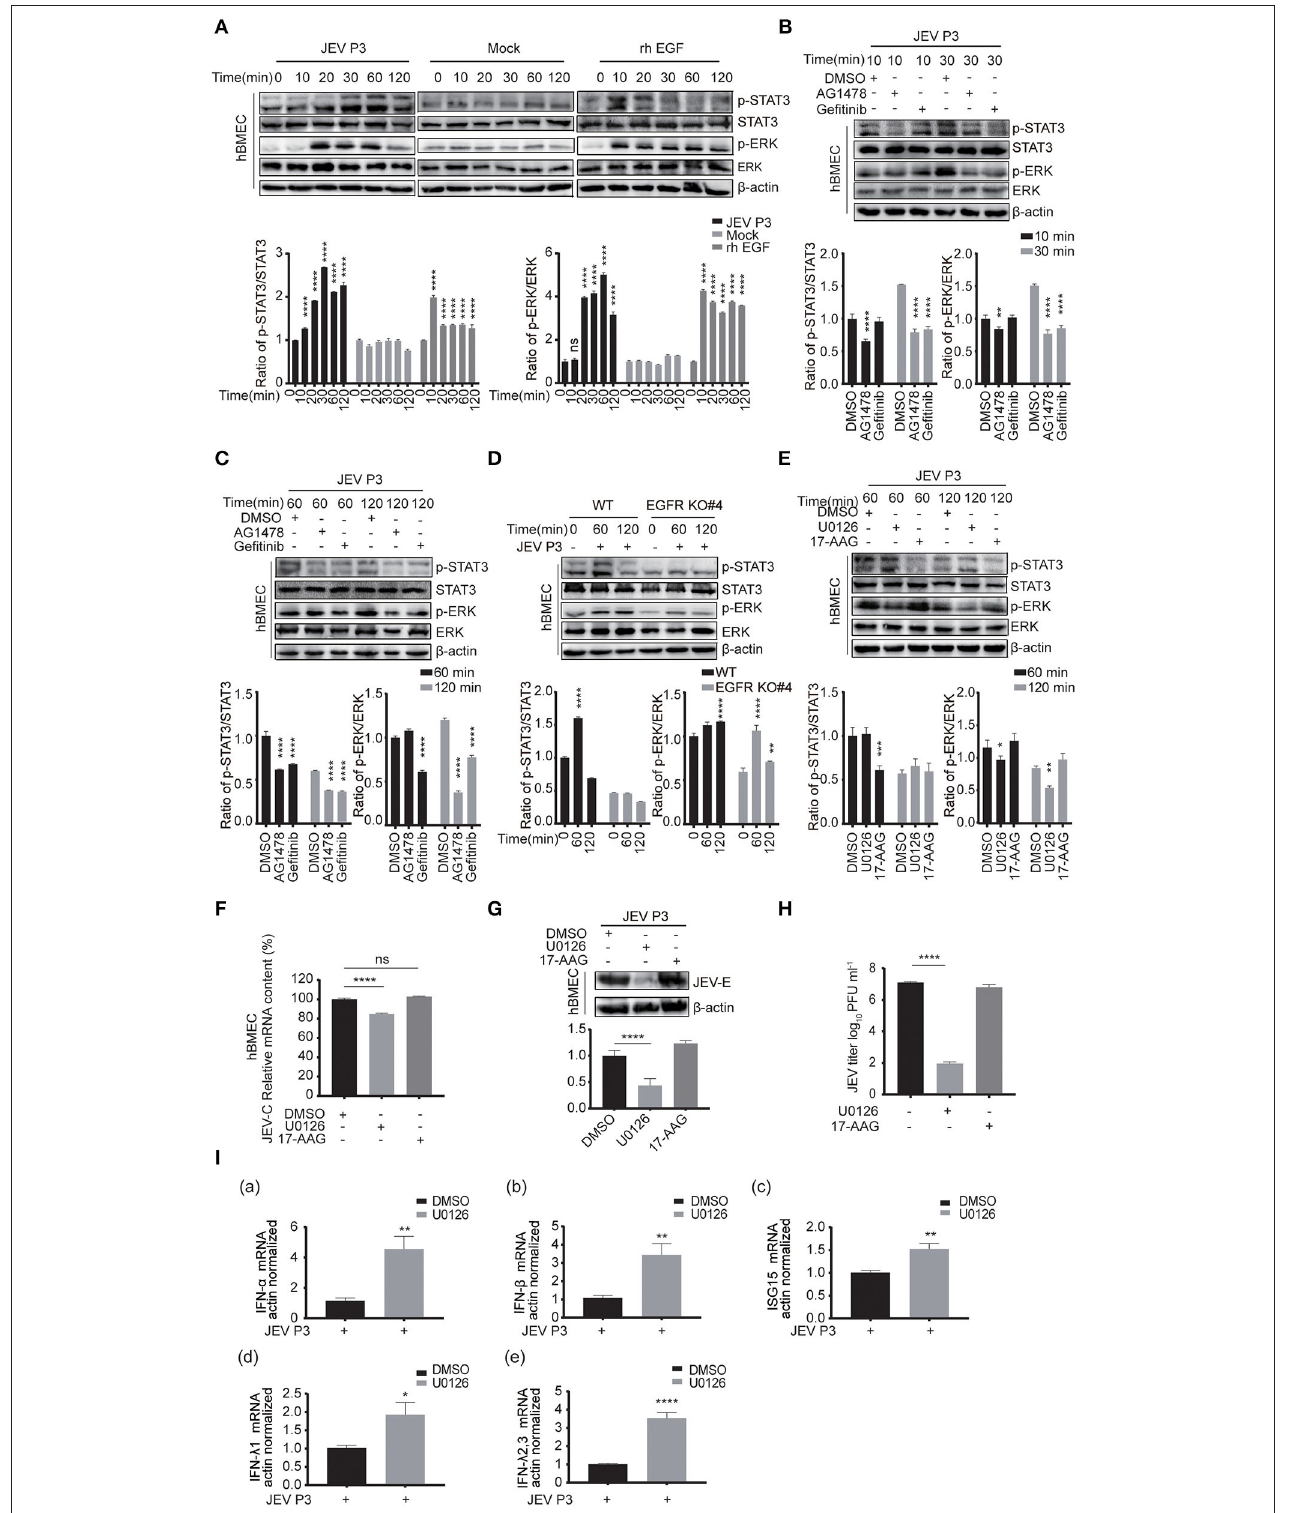
FIGURE 6 | ERK signaling participated in EGFR-regulated host antiviral response by activating interferon signaling. (A) Both JEV P3 and rhEGF induced the phosphorylation of ERK and STAT3 in hBMECs. hBMECs were treated with JEV P3, rhEGF, or DMEM for 0, 10, 20, 30, 60, and 120min. The expression of p-ERK, ERK, p-STAT3, and STAT3 were determined by Western blotting analysis with specific antibodies, while the expression of β -actin was detected as a loading control.